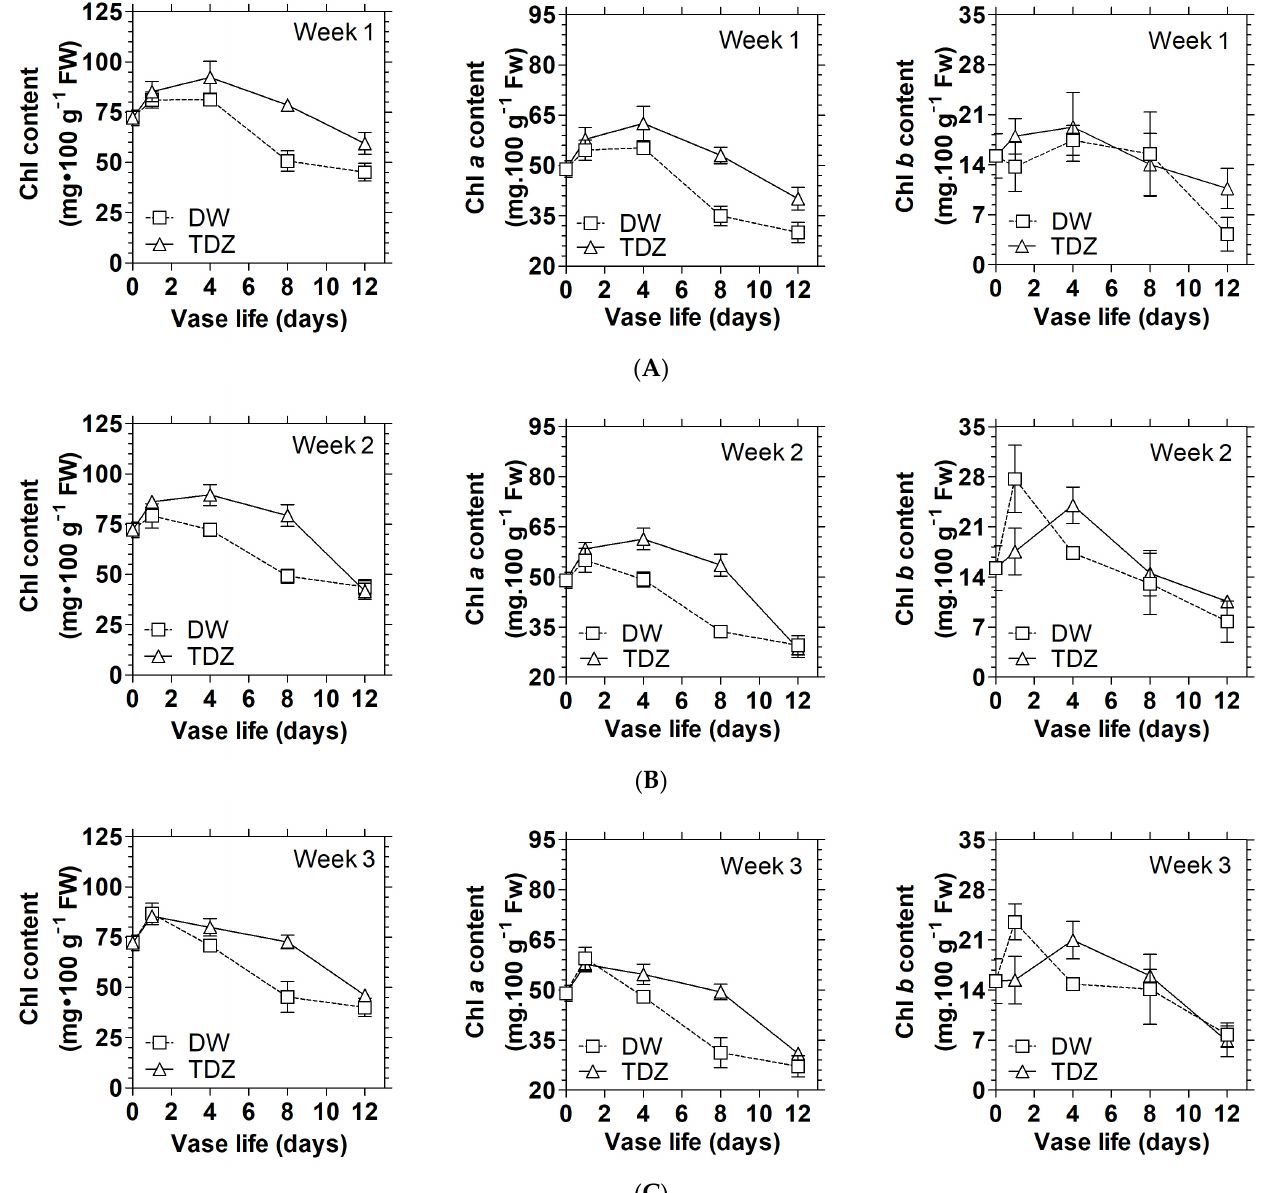
Figure 5. Effect of TDZ and MAP on the contents of total Chl ( A ), Chl a ( B ) and Chl b ( C ) in D. solida leaves after storage. Leaves were pulsed with 10 µ M TDZ and distilled water (DW; control), then packed in BOPP bag, and stored at 10 ◦ C under cool-white fluorescent lights for a 12-h photoperiod for 1, 2 and 3 weeks. After storage, ferns were transferred to distilled water in a controlled environment room for the vase